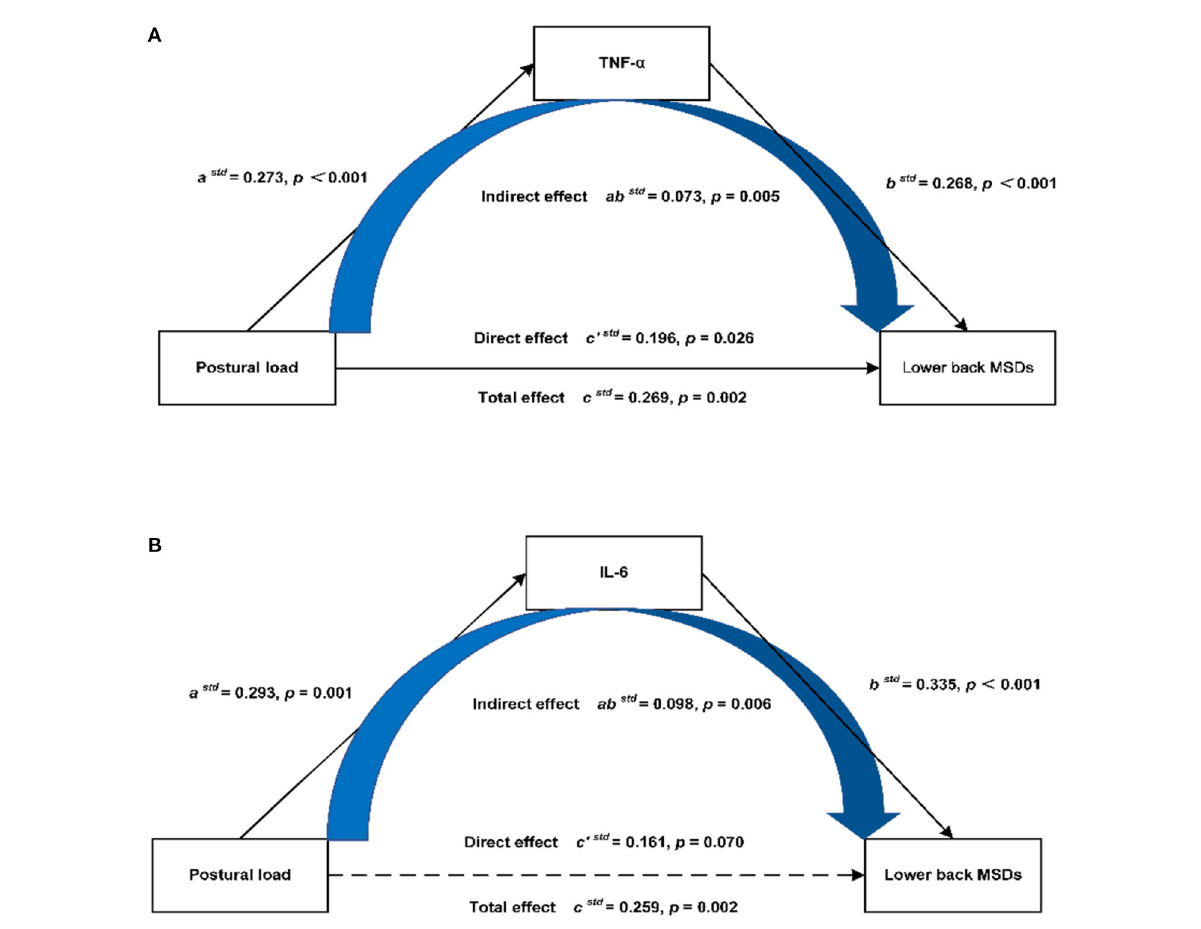
FIGURE3 Mediation model of postural load on the lower back MSDs through inflammatory cytokines. (A) Mediation model of postural load on the lower back MSDs through TNF- α , (B) Mediation model of postural load on the lower back MSDs through